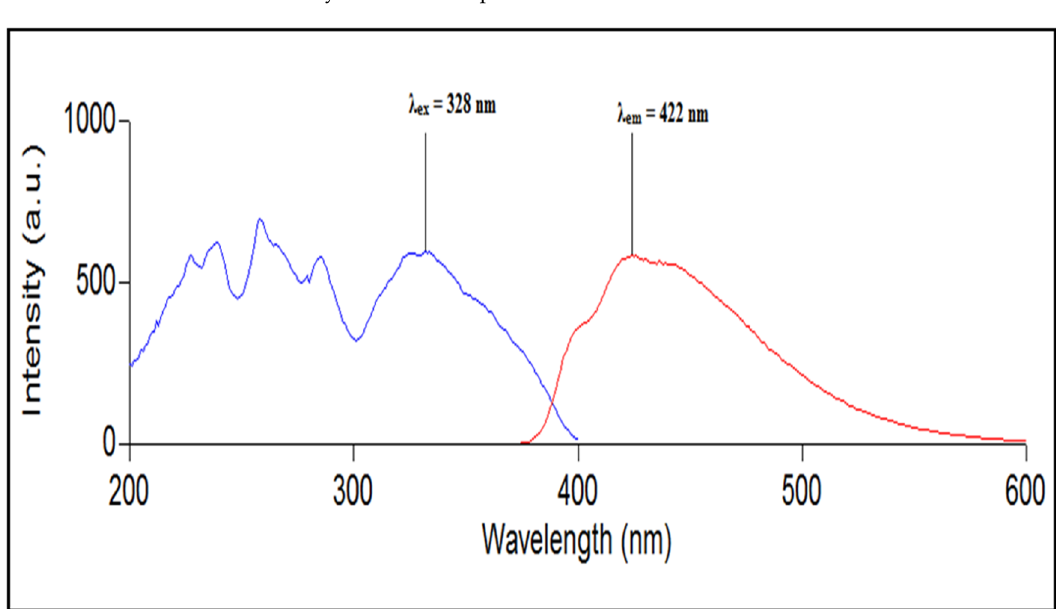
Scheme 1. Synthesis of compound 2.